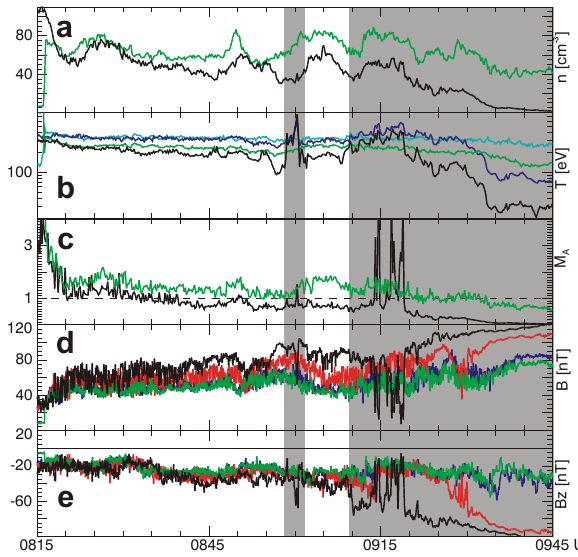
Fig. 3. Cluster plasma and magnetic field observations for 2 Febru- ary 2003, 08:15–09:45 UT. From top to bottom are shown den- sity, parallel and perpendicular temperatures, M A , magnetic field strength, and GSM Z-component. Perpendicular temperatures in panel (b) are shown in purple for Rumba and in turquoise for